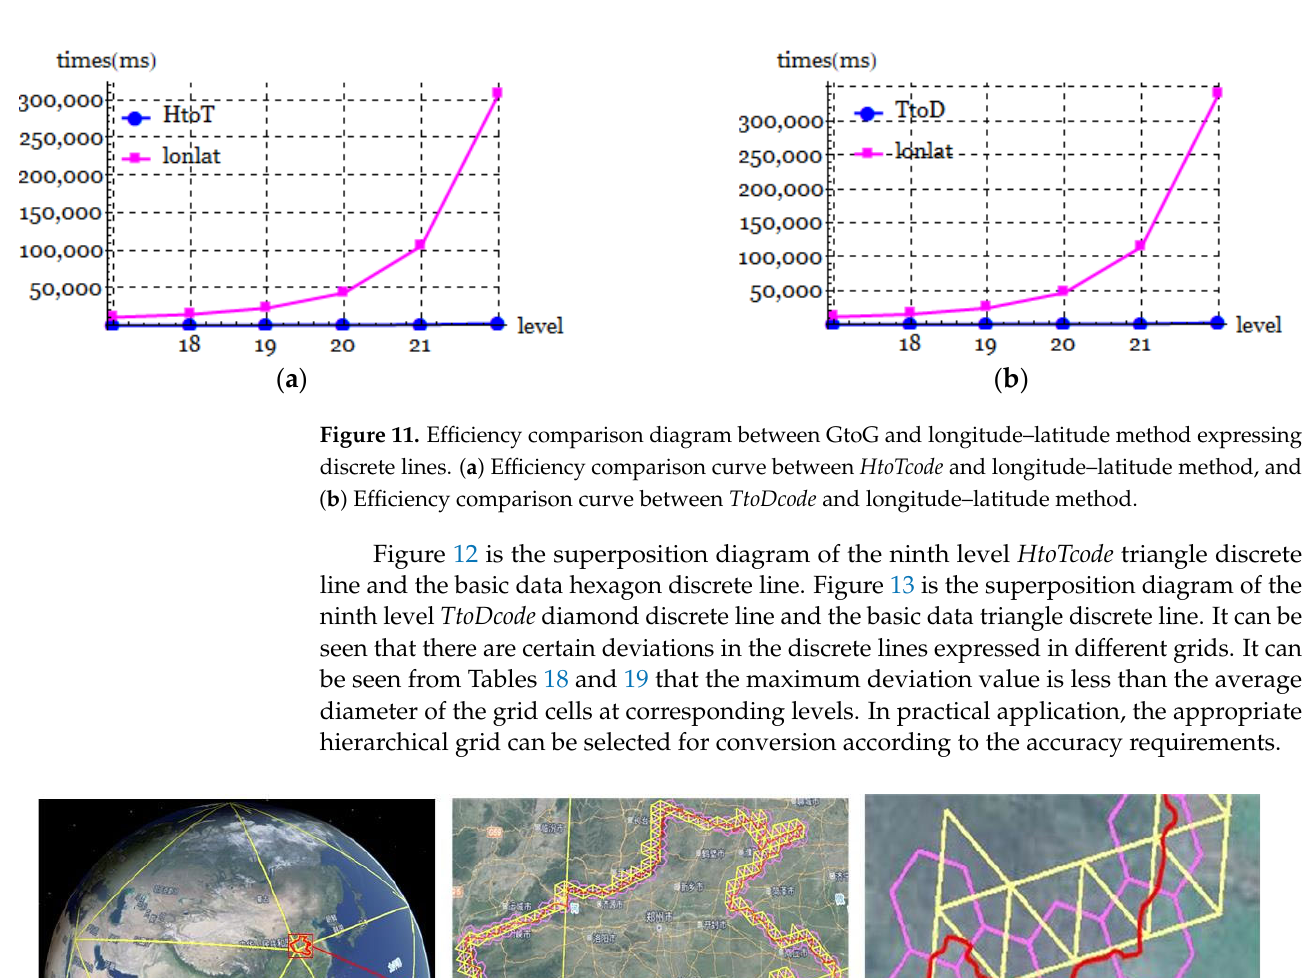
22 of 33 Table 19. Comparison of efficiency and accuracy of TtoDcode and longitude–latitude expressing discrete lines. Level TtoDcode Effi ‐ ciency (ms)